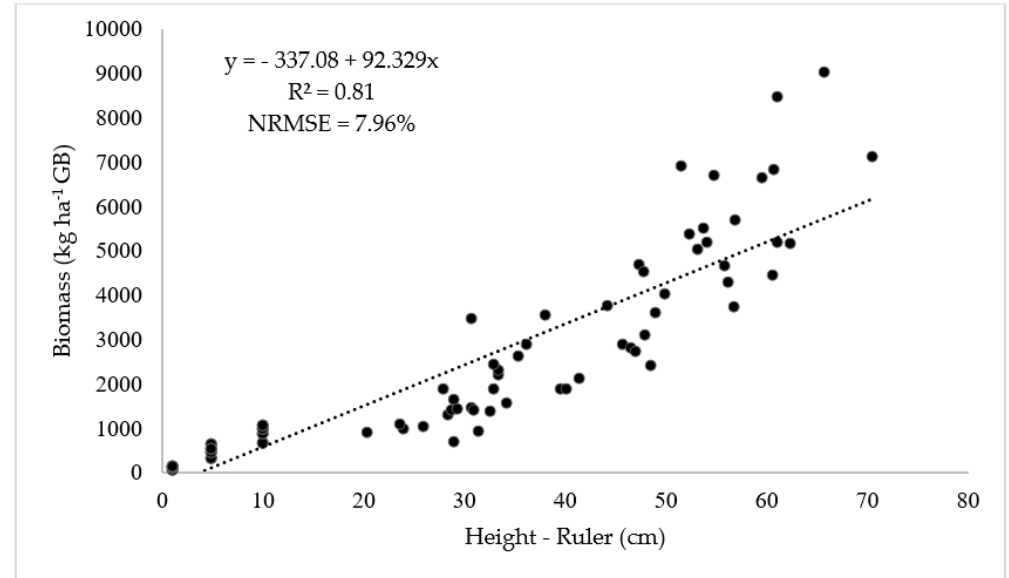
Figure 5. Relationship between biomass and height measured with the ruler.